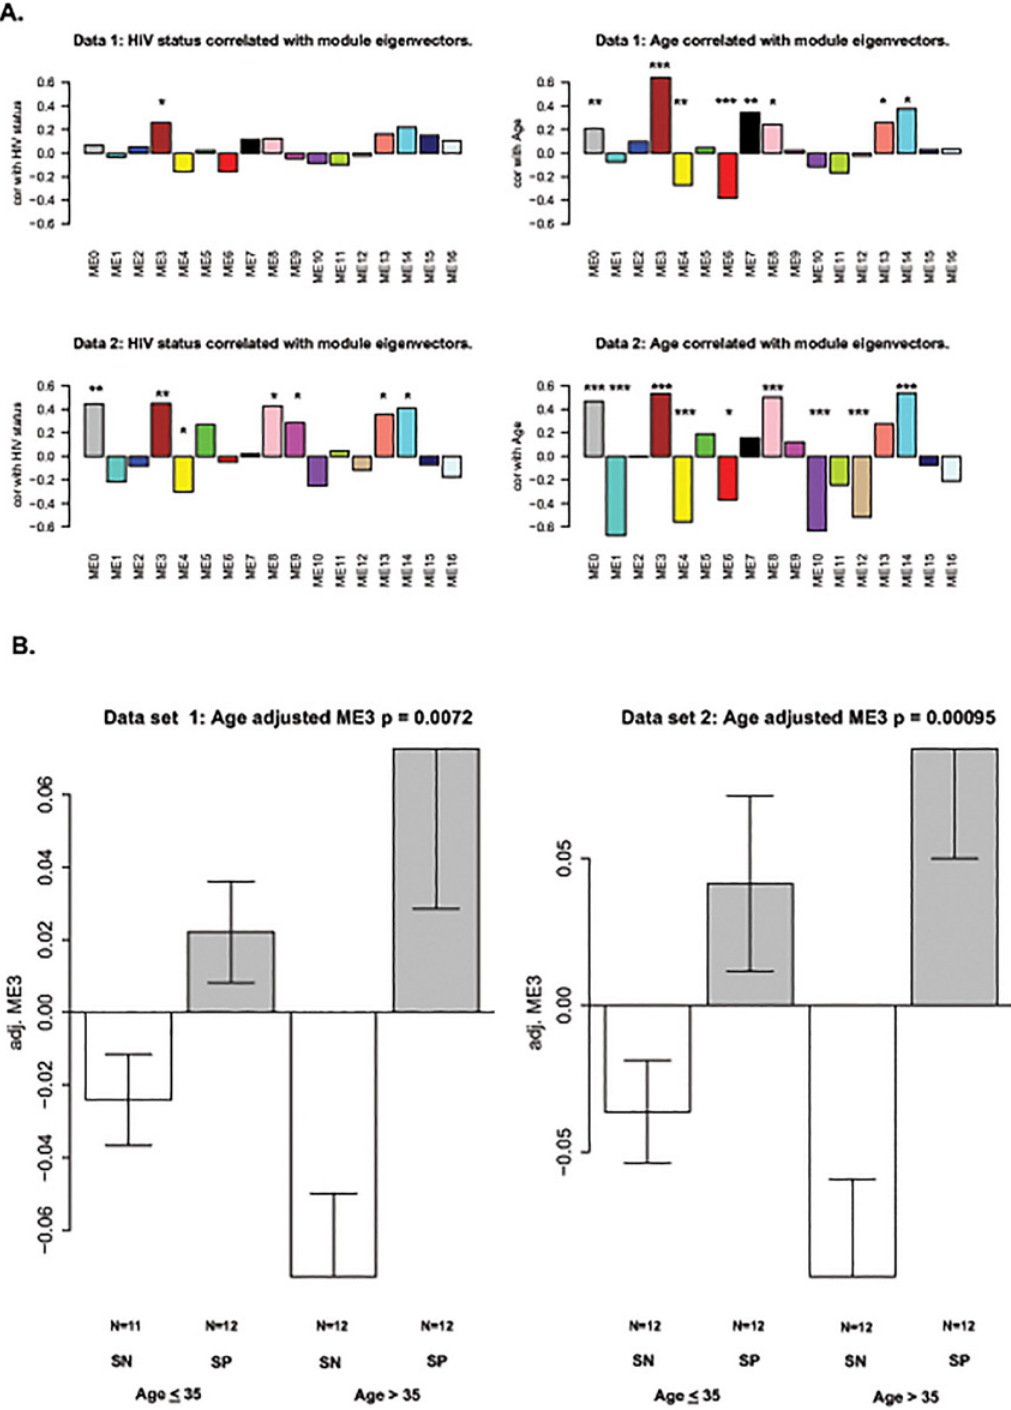
Fig 2. Relating modules to HIV-status and age. Co-methylation modules for HIV-1 status and aging (A) were identified using the blockwise modules function in WCGNA R package. The significant p values for the modules are indicated as follows: * = p (cid:3) 0.05, ** = p (cid:3) 0.01, *** = p (cid:3) 0.001 (B) A box plot depicting module 3 versus age and HIV